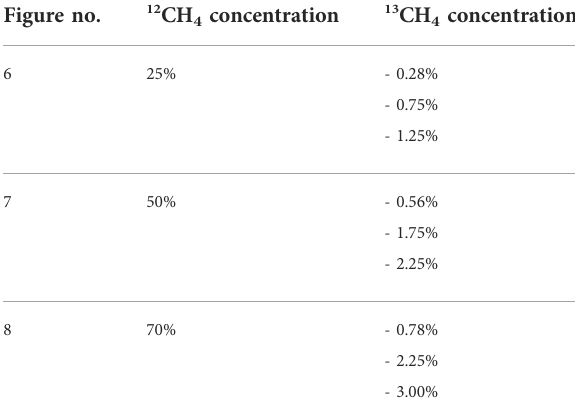
TABLE 1 12 CH 4 and 13 CH 4 concentrations of the nine investigated mixtures (rest: N 2 ). Figure